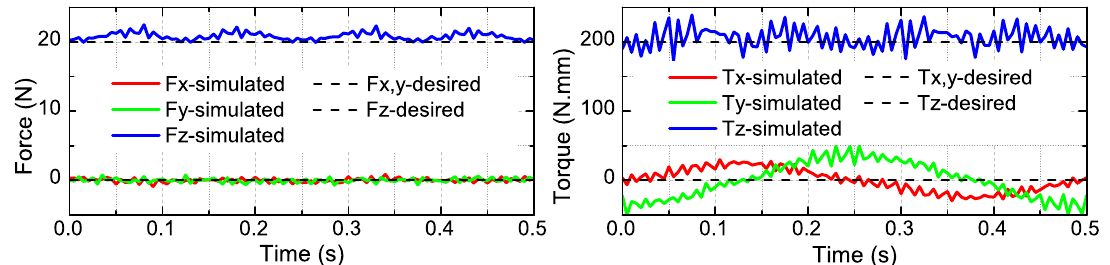
Figure 9. Magnetic force and torque simulation results solved by Radia TM using current solutions from the real-time numerical current decoupling unit shown in Figure 8.